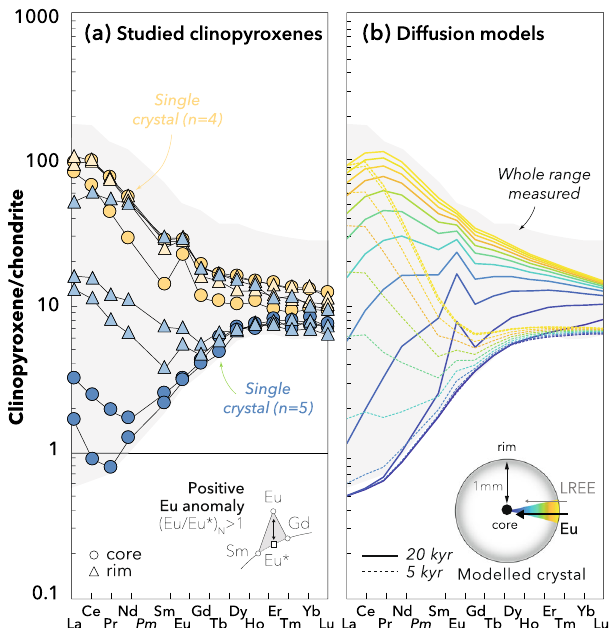
Fig.1|EuropiumanomaliesandprogressiveLREEenrichmentinmeasuredand modelled clinopyroxene crystals. Measured core and rim compositions from single crystals and the whole measured range ( a ) are compared to core-to-rim pro fi lessimulatedafter5kyrand20kyr( b )bythepercolation-diffusionmodel(see Methods). Data are normalised to the chondrite compositions of McDonough and Sun 76 . All the analytical data are reported in Supplementary Data 1. Pm con- centrations are